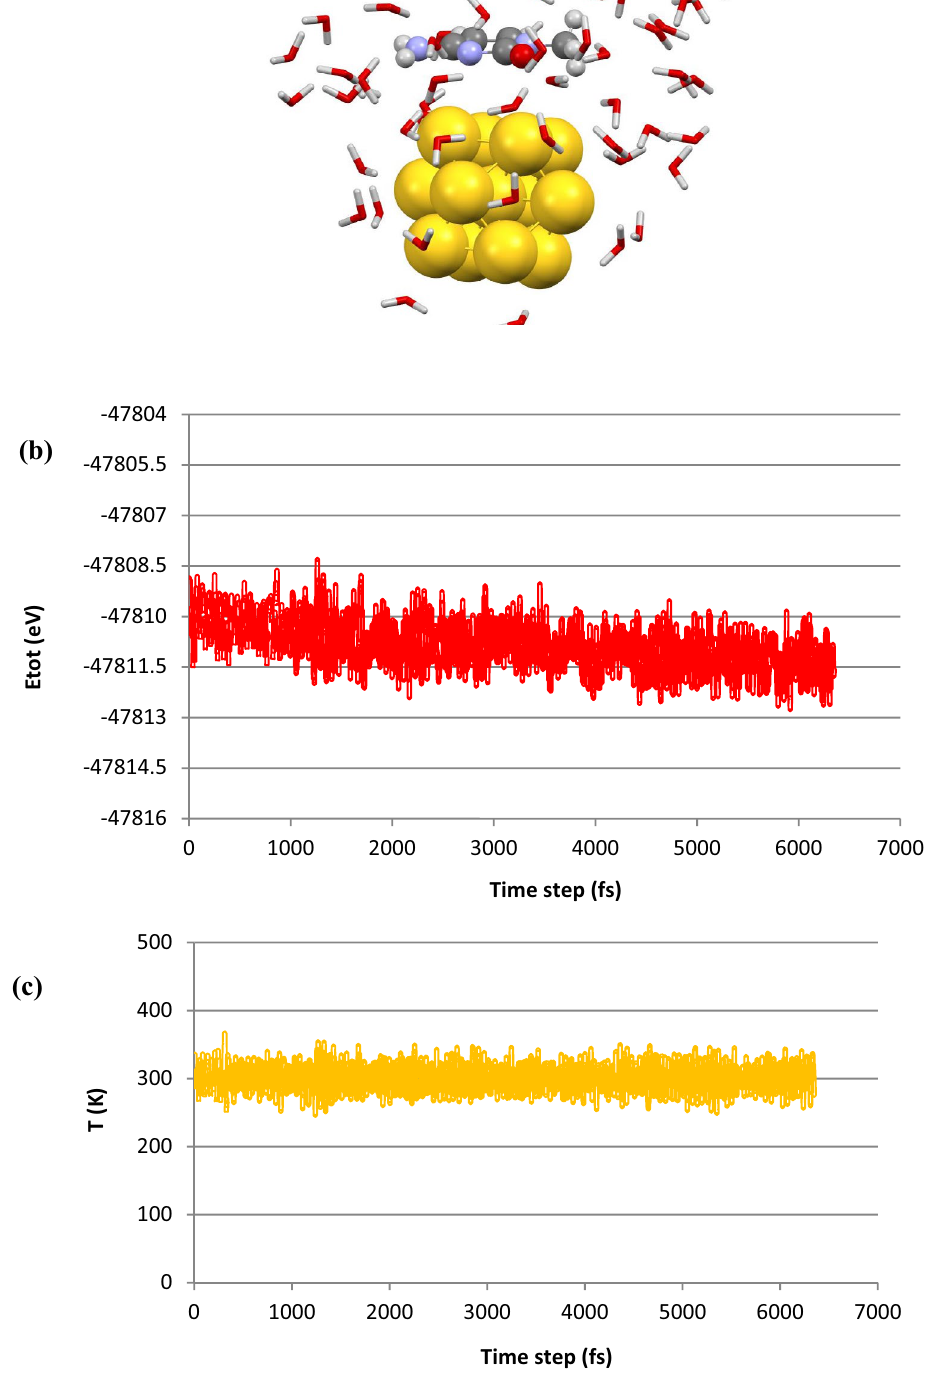
Figure 5. Representation of ( a ) initial model of cytosine/Au13/70H 2 O system considered for DFT - MD simulation. Calculated plots of ( b ) temperature and ( c ) total energy obtained during the DFT ‒ MD simulation procedure for cytosine-Au13/70H 2 O system. Snapshot of the molecular structure of cytosine-Au13/70H 2 O at 12 ps representing bond distances between water molecules and ( d ) NH 2 and ( e ) O groups. Bonding distances between ( f ) C, ( g ) N, and ( h ) O atoms and nearest Au atom during the 8.5 ps of simulation